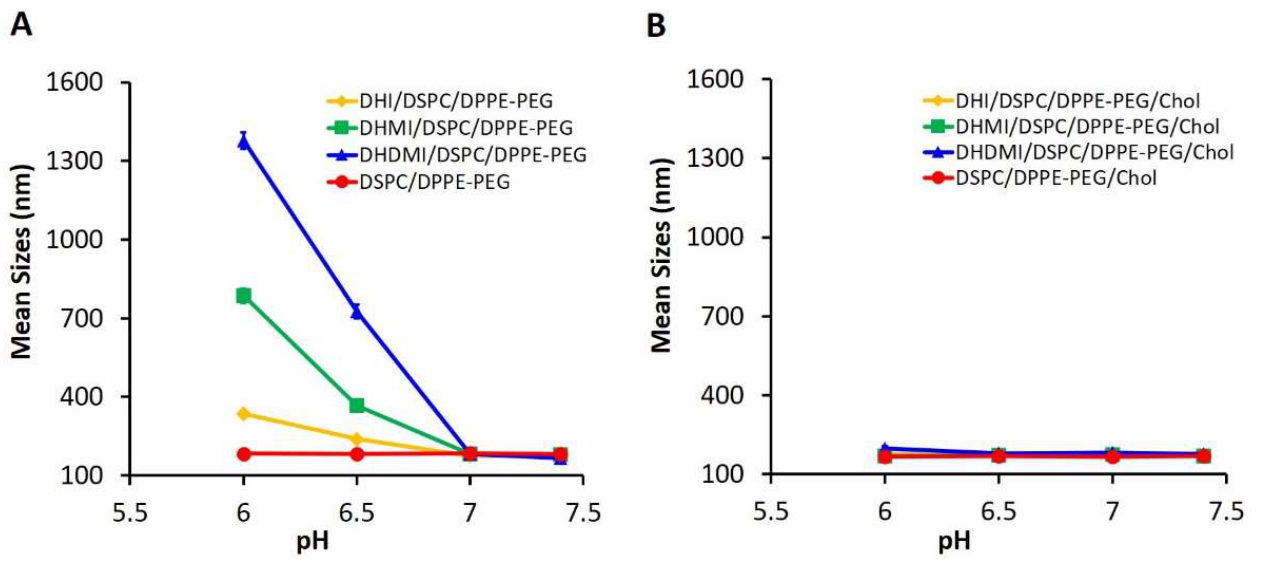
Figure 5. pH-triggered interaction between ICL and model liposomes. Mean sizes of equimolar mixture of model liposome and ICL without ( A ) or with ( B ) 25% cholesterol were measured at 37 °C, pH 6.0, 6.5, 7.0, and 7.4. Data are presented as mean ± SD, N = 3.